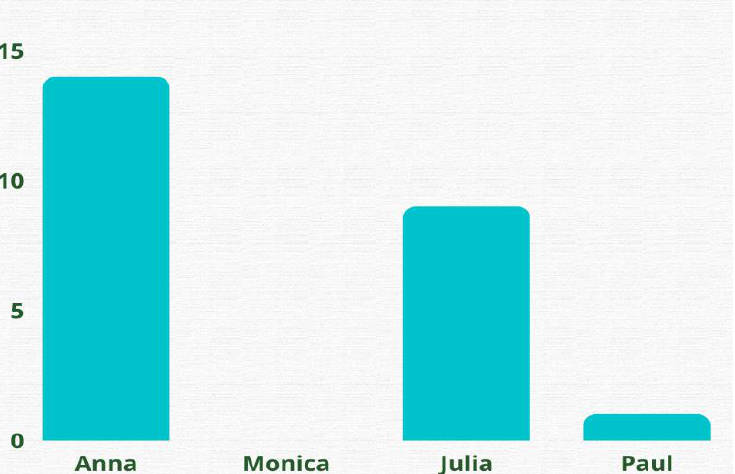
Figure A1. Looking at Your Role in the Context in Which You Work, in Which Persona Do You Most Identify (n = 19)? Note: option to choose more than one answer.